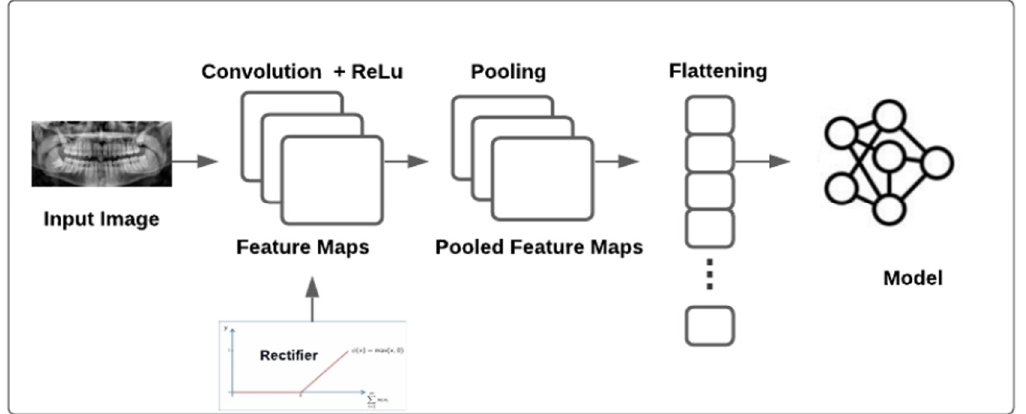
Figure 4. The proposed model